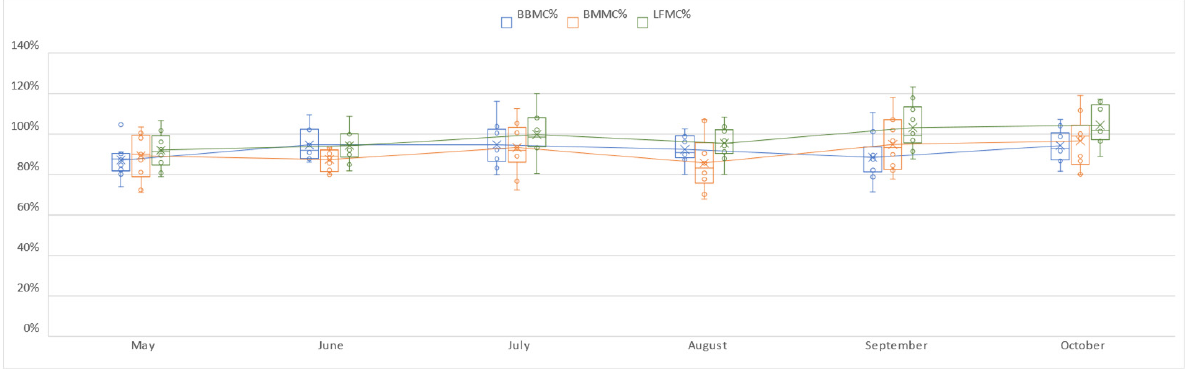
Table 2. Results of the analysis of variance (ANOVA) among BBMC%, BMMC% and LFMC%.